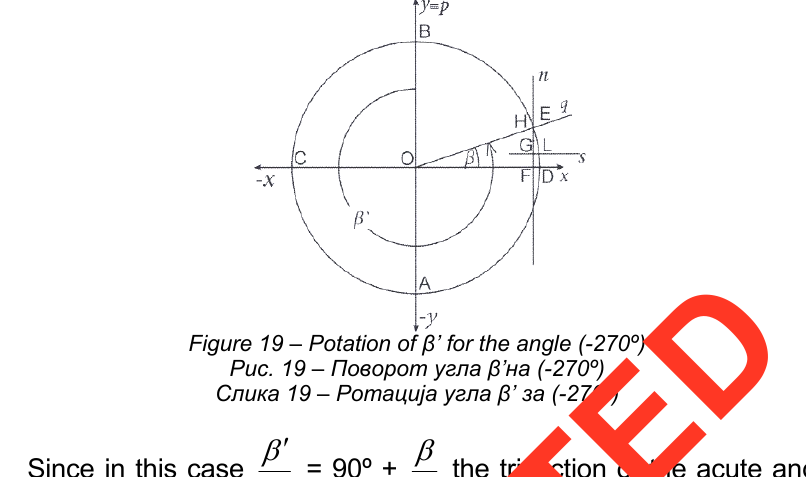
Figure 19 – Р otation of β ’ for the angle (-270º) Рис . 19 – Поворот угла β ’ на (-270º) Слика 19 – Ротација угла β ’ за (-270º)